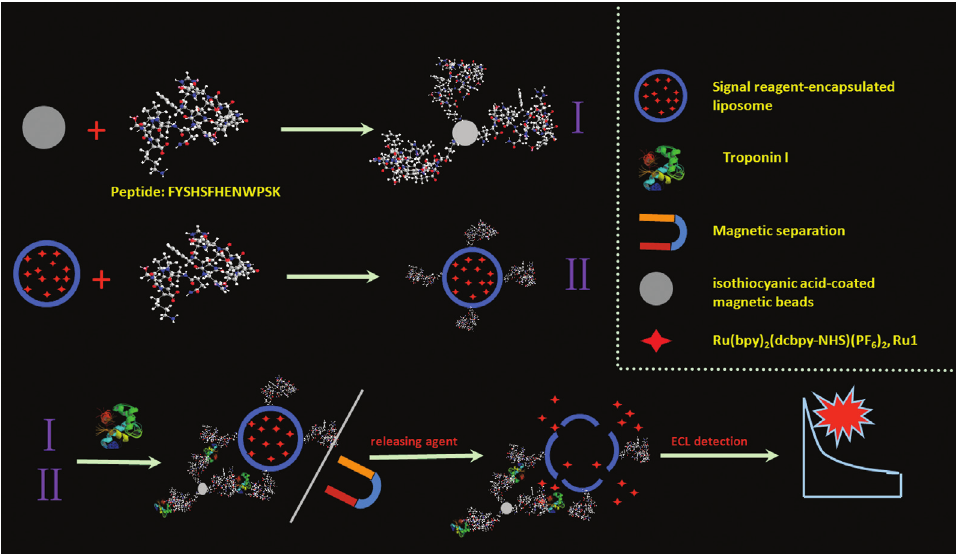
Figure 2 Schematic diagram of the liposome peptide-based ECL method for the determination of cTnI. Reprinted with permission from Qi et al. (2013). © 2013 American Chemical